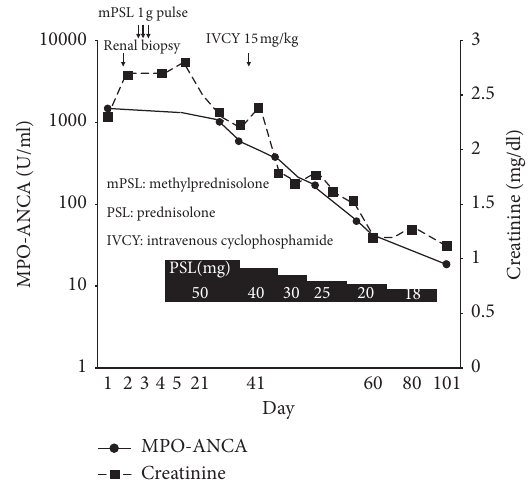
Figure 3: Clinical course of this case. The combination therapy with mPSL and IVCY was effective for improving the renal function of the patient and decreasing the titer of MPO-ANCA in this case. MPO-ANCA is displayed logarithmically. mPSL � me- thylprednisolone, PSL � prednisolone, and IVCY � intravenous